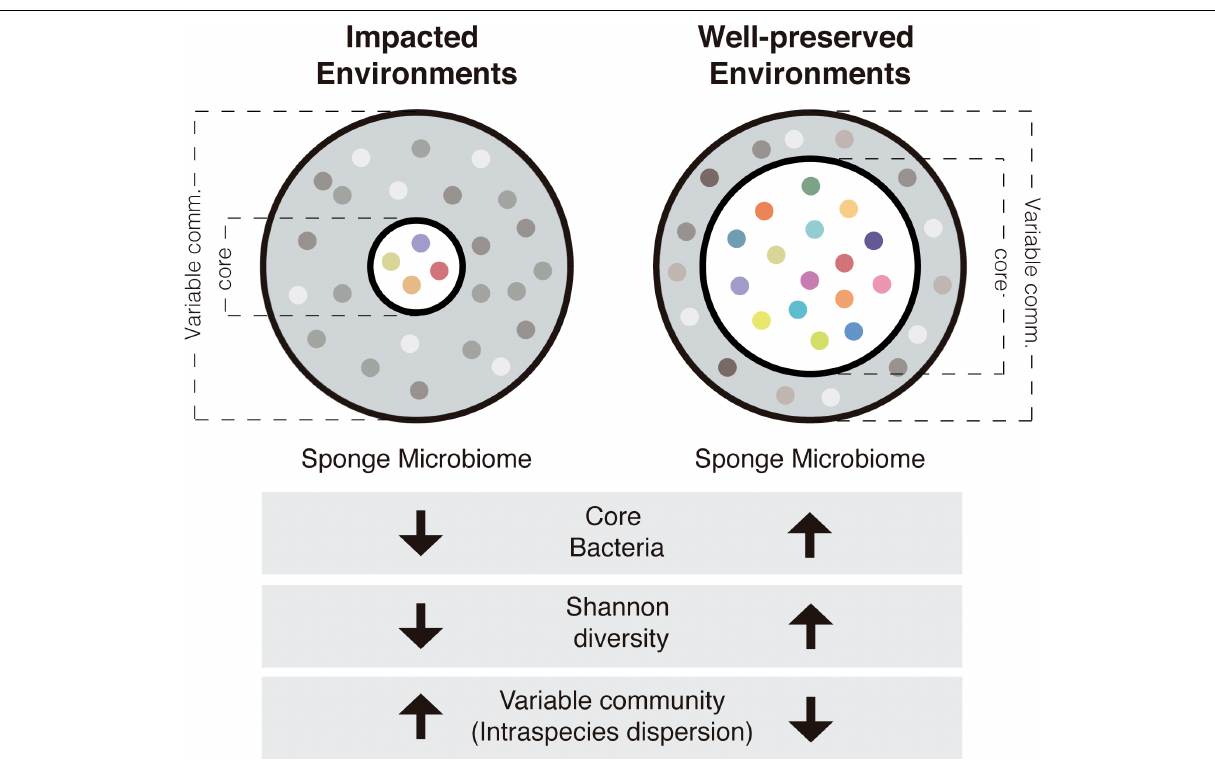
FIGURE 5 | Schematic representation of the sponge microbiomes in impacted and well-preserved environments. Gray fraction represents the variable community and white fraction represents the core community. Each colored dot corresponds to a single bacterial